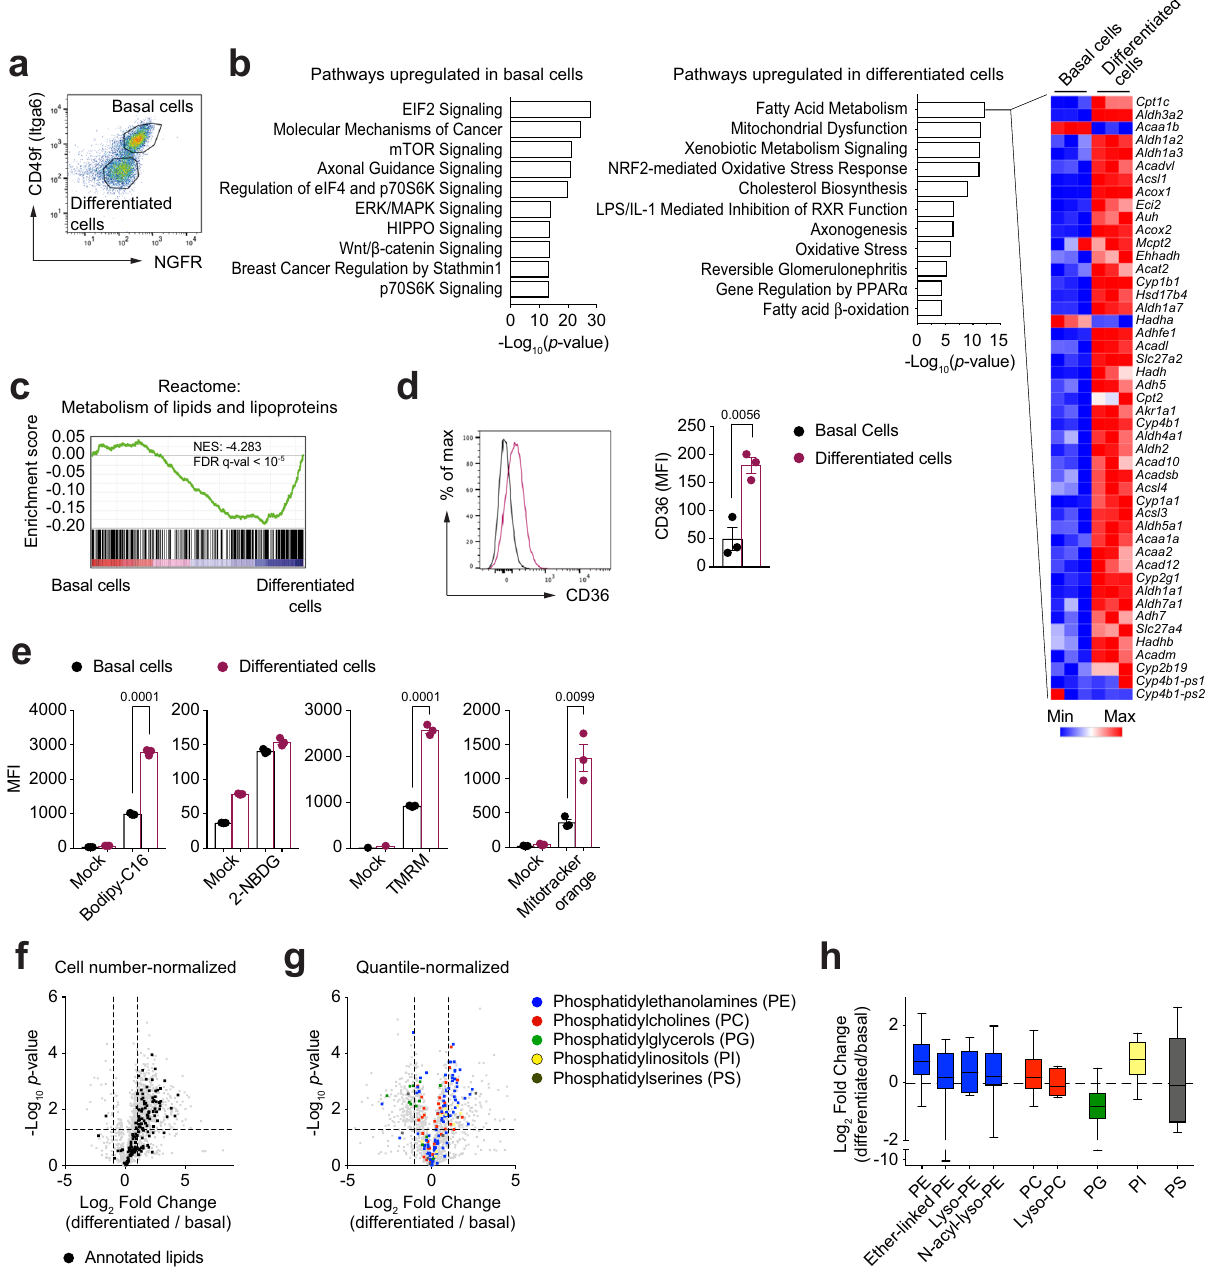
Fig. 1 | Rewiring of cellular metabolism accompanies airway epithelial cell differentiation. a FACS gating strategy of murine tracheal epithelial cell cultures (mTEC) collected at ALI day 10 (CD49f + NGFR + basal cells; CD49f − NGFR − differ- entiated cells). b Ingenuity Pathway Analysis of differentially expressed genes obtainedfromtheRNAsequencingofbasalanddifferentiatedcells( p adj<0.01),to identify differentially regulated pathways. The indicated Log 10 ( p -values) were cal- culated using the Fisher ’ s Exact test. The heatmap showing the expression of transcripts related to the ‘ fatty acid metabolism ’ pathway was generated using the Broad Institute ‘ Morpheus ’ software. c Gene set enrichment analysis (GSEA) of the ‘ metabolism of lipids and lipoproteins ’ pathway. NES: normalized enrichment score; FDR: false discovery rate. d Flow cytometry analysis of CD36 expression on the surface of basal and differentiated cells at ALI day 10. Data show geometric mean+/ − SD. Two-tailed unpaired Student ’ s t test; n =3 biologically independent samples representative of 3 independent experiments. MFI: mean fl uorescence intensity. e FlowcytometryanalysisofmTECcultures(ALIday10)exposedtoeither